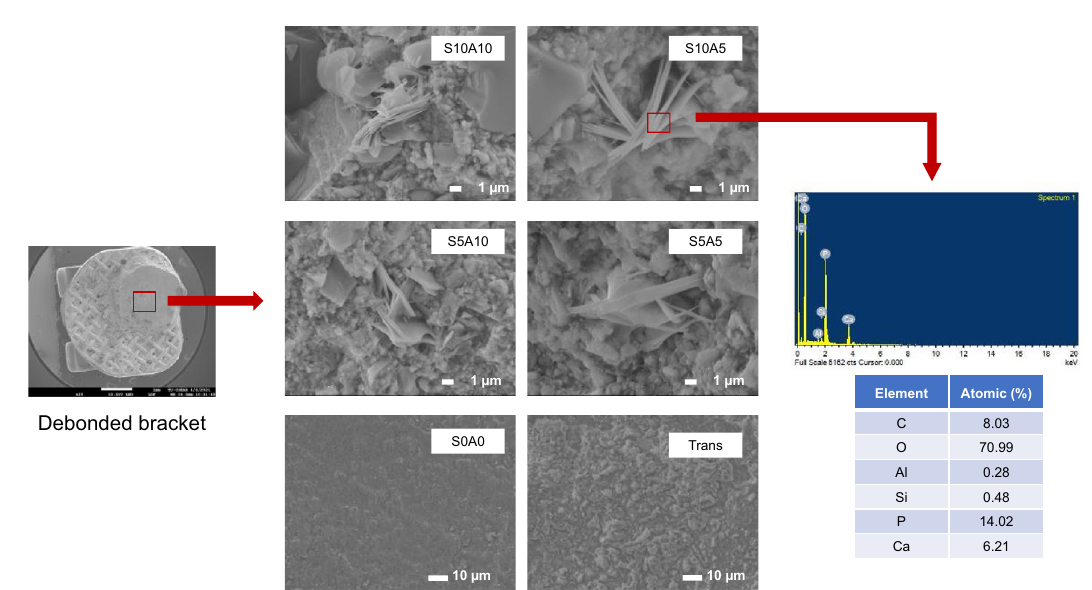
Figure 4. Surfaces of the adhesives of the representative specimens after debonding from enamel. Precipitates (arrows) were detected in all groups except for S0A0 and Trans. An example of the EDX results from the precipitation showed that the main elements contained in the precipitate crystals are Ca and highest and lowest concentrations were detected from S10A5 (3.44 ± 0.10 ppm) and S5A5 (1.22 ± 0.03 ppm) (Fig. 5B). Likewise, the highest and lowest Sr concentrations were detected from S10A5 (1.99 ± 0.73 ppm) and S5A5 (0.85 ± 0.22 ppm) (Fig. 5C). The factorial analysis demonstrated that an increase in Sr/CaP from 5 to 10 wt% increased the amounts of released Ca and P by 141 ± 19% and 119 ± 4%, respectively. The effects of increas- ing the concentrations of Sr/CaP and Andro on the release of Sr were negligible. Influence on the growth of S. mutans. The highest and lowest amounts of S. mutans were detected from the blank control (3.8 ± 0.1 Log CFU/mL) and S10A5 (2.6 ± 0.3 Log CFU/mL) (Fig. 6). The value of S10A5 was significantly lower than that of the blank control ( p < 0.01). The amount of S. mutans in S10A5 was comparable to those in S10A10 (2.8 ± 0.1 Log CFU/mL), S5A10 (3.6 ± 0.1 Log CFU/mL), S5A5 2.9 ± 0.2 Log CFU/mL, S0A0 (3.1 ± 0.5 Log CFU/mL), and Trans (3.5 ± 0.1 Log CFU/mL) ( p > 0.05). Factorial analysis showed that an increase